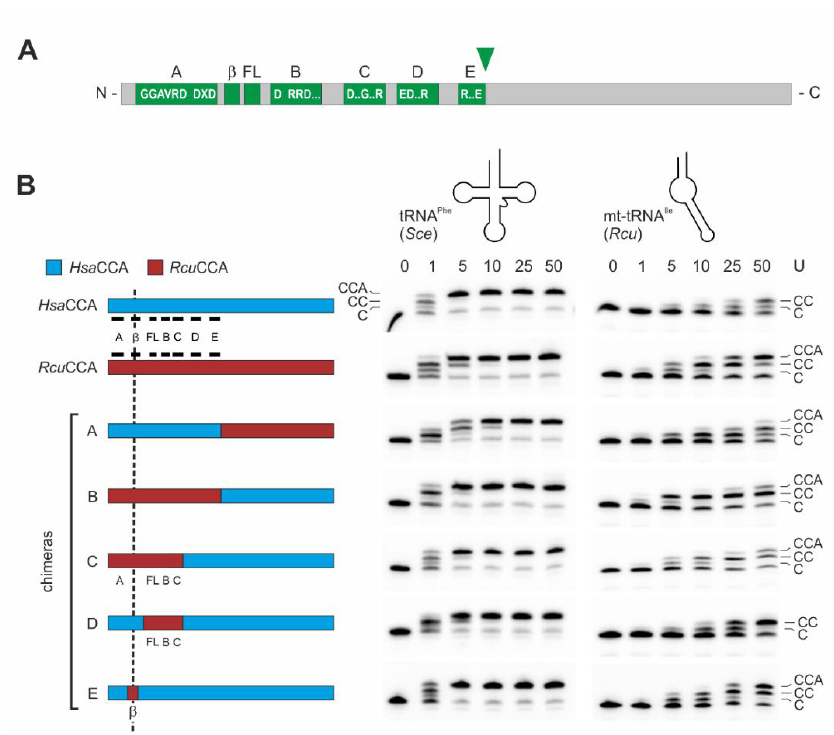
Figure 3. Catalytic activity of wild-type and chimeric enzymes on tRNA Phe and mt-tRNA Ile . ( A ) Bar representation of class II CCA-adding enzymes. The N-terminal region contains the catalytic core consisting of five motifs A to E, a β -turn element ( β ) and a flexible loop (FL). The green arrowhead indicates the fusion position for enzyme chimeras A and B. ( B ) Left: Bar representation of tested enzyme chimeras consisting of Hsa CCA (cyan) and Rcu CCA (red) regions. Catalytic core elements are indicated in black. The reciprocal chimeras A and B are fused after position E213, downstream of motif E. The replaced β -turn element ( β ) in chimera E is located between motif A and the flexible loop (FL). Gel panels: CCA-addition on the conventional tRNA Phe from yeast ( Sce , left) and the armless mt-tRNA Ile from R. culicivorax ( Rcu , right) with increasing amounts of enzymes indicated as arbitrary units (U). All enzymes catalyze an e ffi cient CCA-incorporation on the conventional